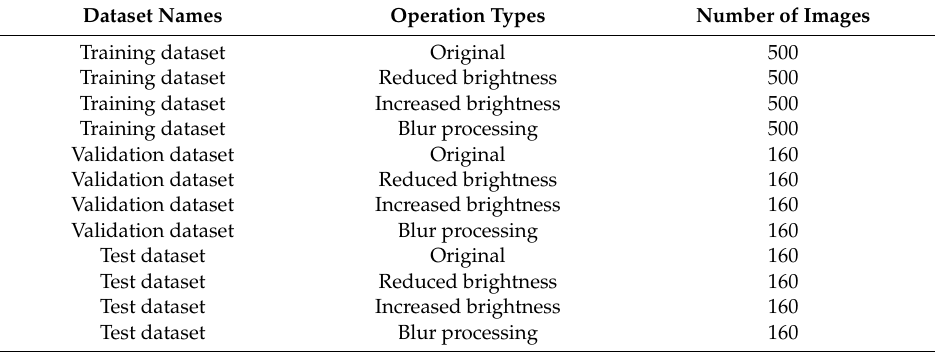
Figure 8. Annotation of maize plants. 3.3 Results and Discussion